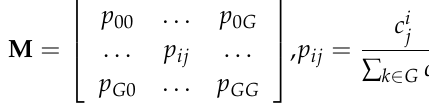
Figure 4. ( a ) trajectory location to peripheral location ( b ) peripheral location to trajectory location.